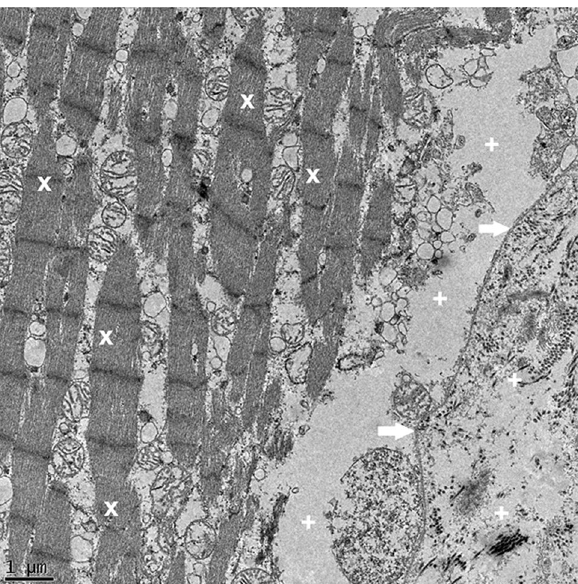
Figure 5. Group3 (G3, stretched to 40%). Stretch G3 TEM image demonstrating anomalous myofibrillar structure (X), abnormal gap between the myofibrills and the cell membrane, enlarged extracellular space (+), and cell membrane disruption from the intracellular structures ( arrows ).